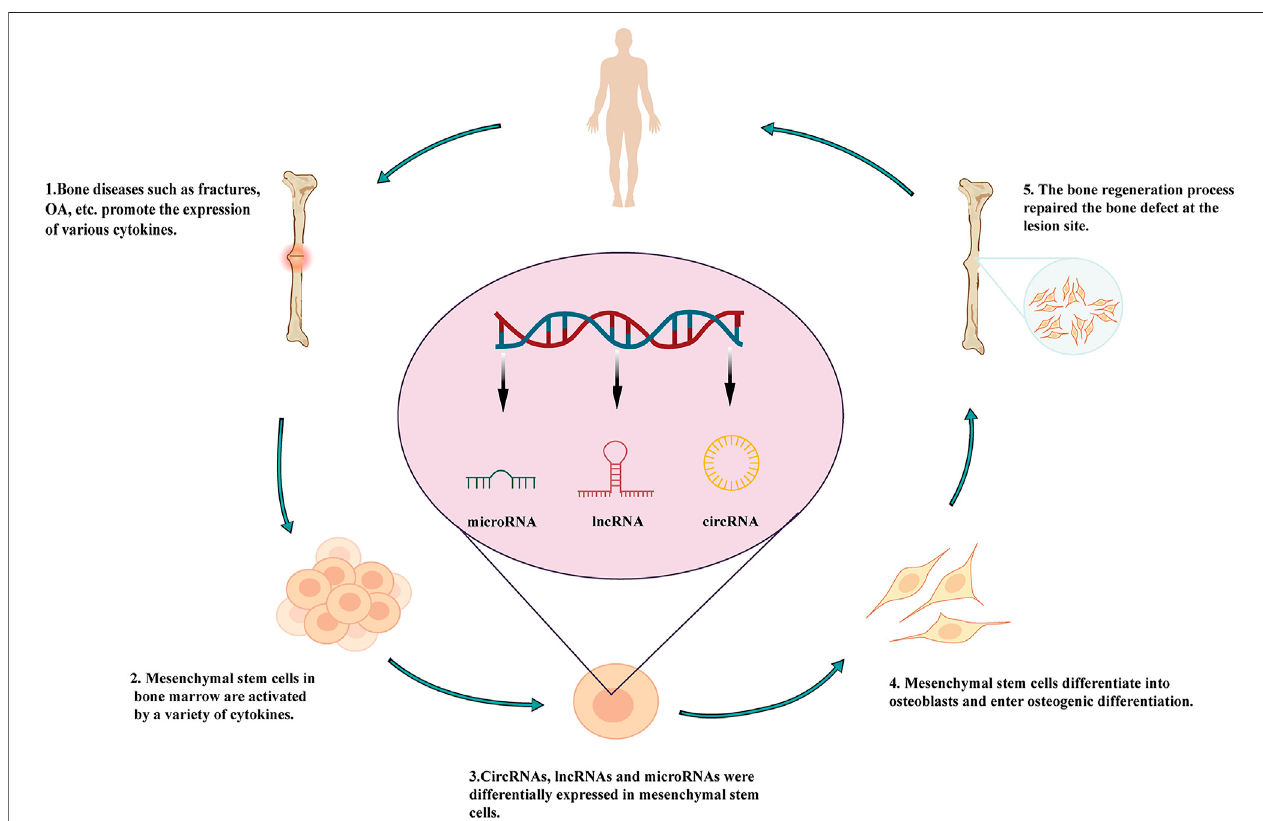
FIGURE 1 | Roles of lncRNAs in the osteogenic differentiation of mesenchymal stem cells and involvement in bone diseases.